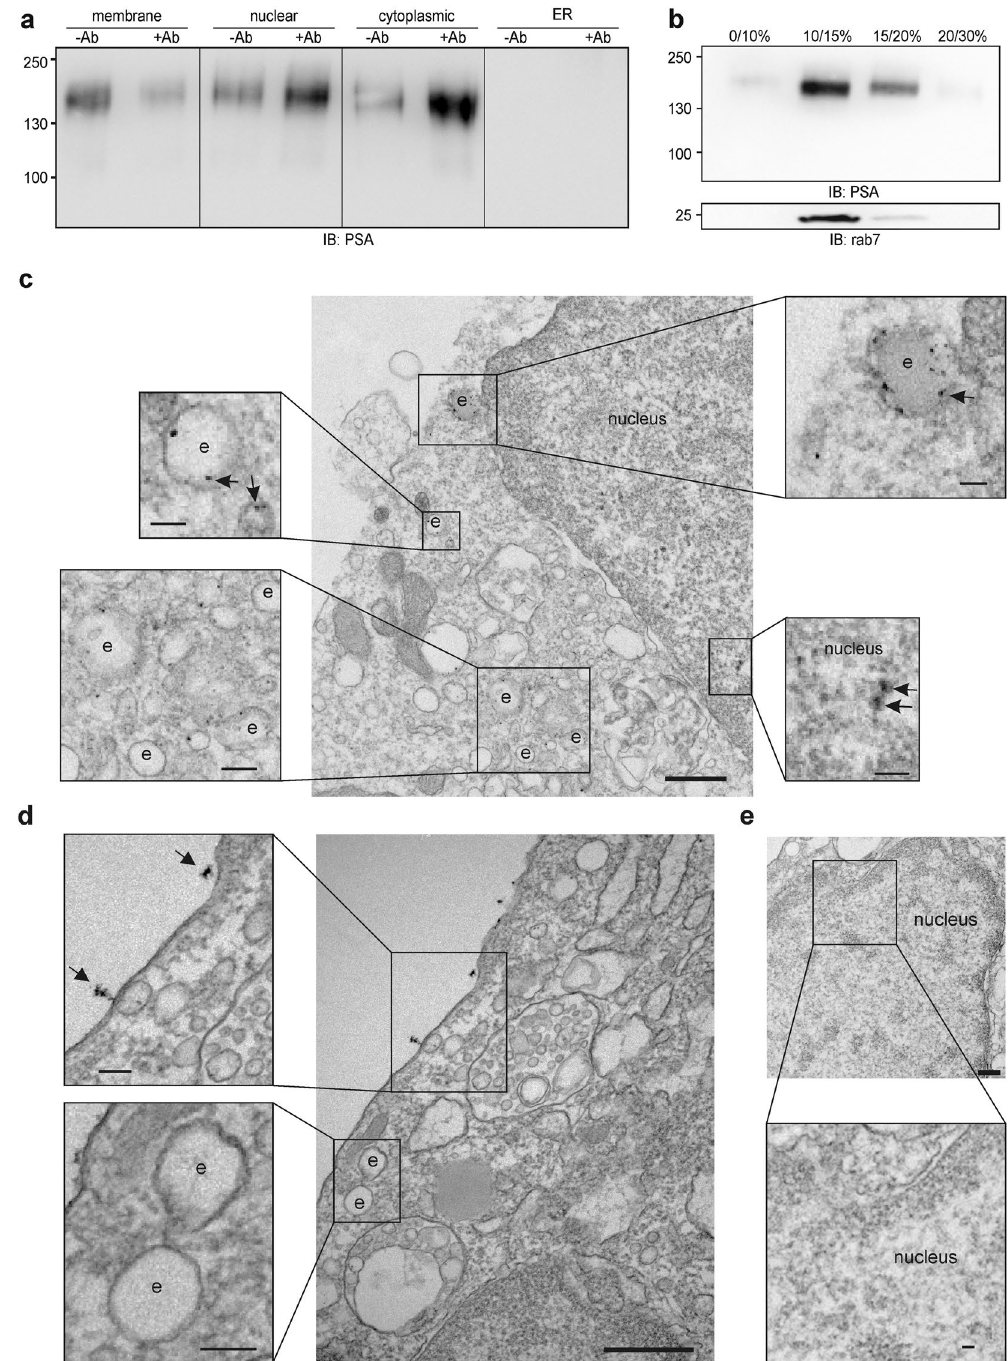
Figure 2. The PSA-carrying NCAM fragment is transported from the cell surface to the nucleus via endosomes. ( a , b ) PSA-NCAM-expressing CHO cells were subjected to cell surface biotinylation, stimulation with chicken NCAM antibody (12.5 µ g/ml IgY) and subcellular fractionation. Biotinylated proteins from membrane, cytoplasmic, nuclear and ER fractions ( a ) and from fractions of an iodixanol step gradient ( b ) were subjected to immunoblot analysis with the PSA antibody or rab7 antibody. Representative immunoblots out of three independent experiments are shown. Lanes that were not adjacent to each other but derived from the same blot are indicated by dividing lines. ( c – e ) Representative electron microscopic images of a cerebellar neuron after treatment with chicken NCAM antibody ( c ) and of a non-treated neuron ( d , e ) are shown (Scale bar: 500 nm). Arrows indicate PSA-NCAM detected by immunogold grains in nuclei and endosome-like structures ( c ) or at the cell surface ( d ). ( e ) Part of the nucleus of a non-treated neuron is shown. ( c – e ) Boxes indicate sections at higher magnification and scale bars in the boxes represent 100